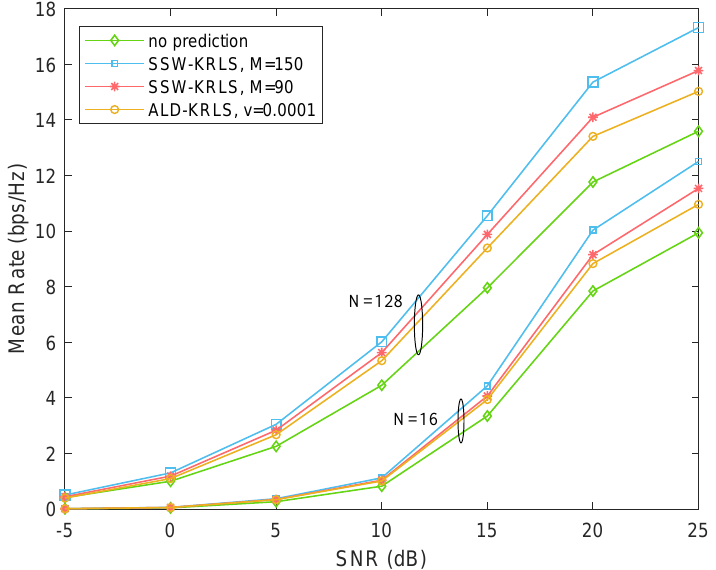
Figure 8. Performance comparison among no prediction (last uplink measurement), the ALD-KRLS algorithm, and the proposed SSW-KRLS algorithm. β = 0.97, v = 120